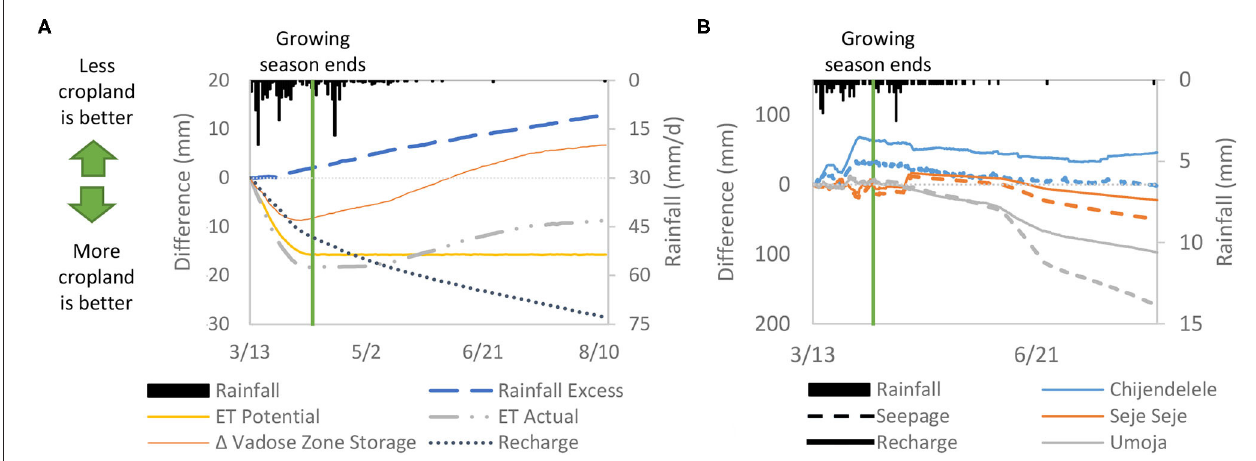
FIGURE 7 | (A) Comparative trends in aggregate overland flow quantities for the Chididimo watershed after increasing cropland. (B) Comparative trends in groundwater flow parameters for each of the three sand dams after increasing cropland. For both (A,B) , a quantity above the y = 0 line indicates that S1 (less cropland) produced values more beneficial to water storage in sand dams than S2. The converse also applies with quantities below the y = 0 line indicating S2 is more beneficial.